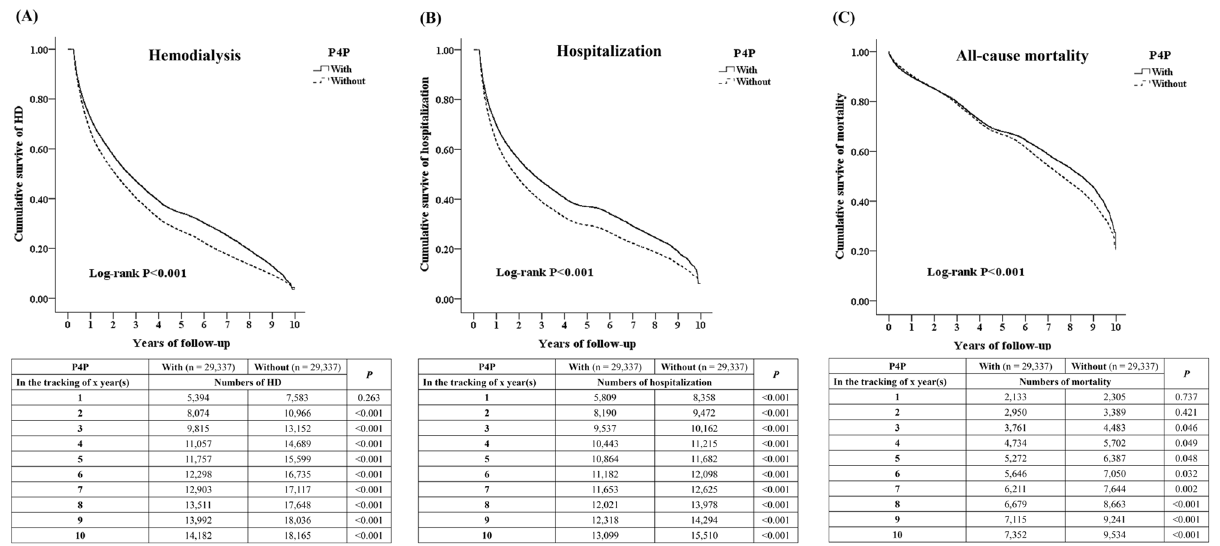
Figure 2. Kaplan–Meier Curves for the Cumulative Incidence of ( A ) Hemodialysis, ( B ) Hospitalization, and ( C ) All-cause Mortality with Log-Rank Test in Patients with CKD Stages 3–5 Enrolled or Not in the Pay for Performance Program